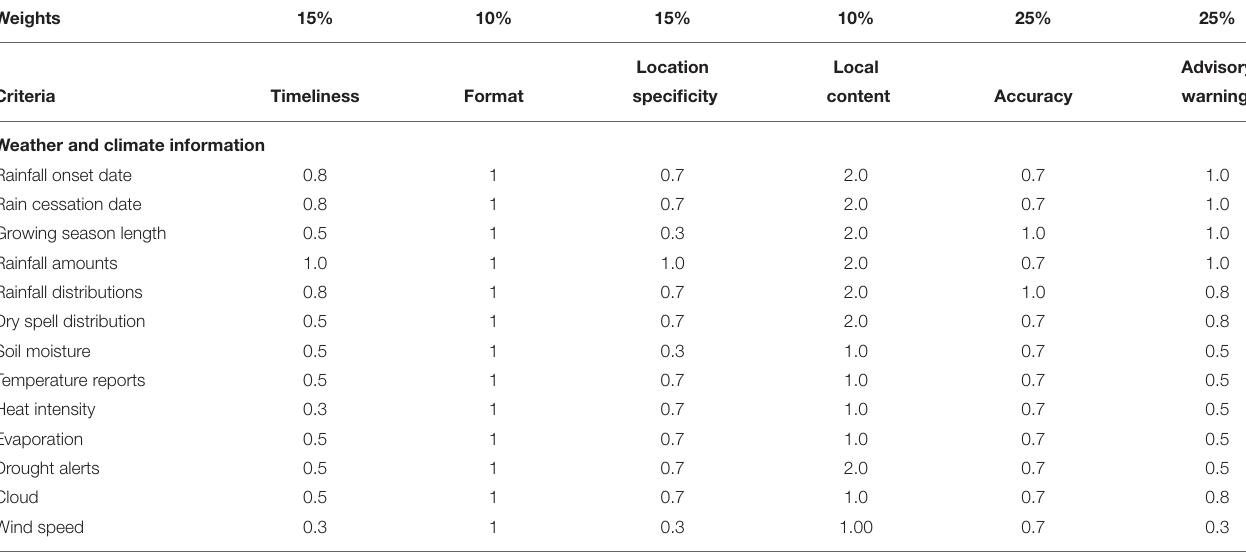
TABLE 8 | Estimates of normalized decision matrix a and relative significances of criteria (criteria weights) (Agriculture).